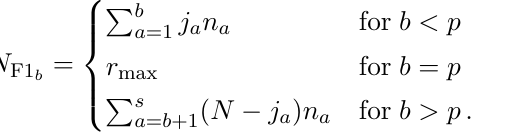
at the top; the 1